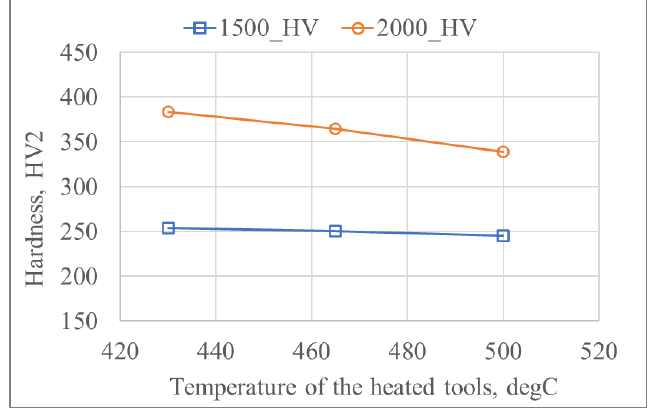
Figure 15. Hardness trend as a function of temperature of heated tools in the condition of greater softening.